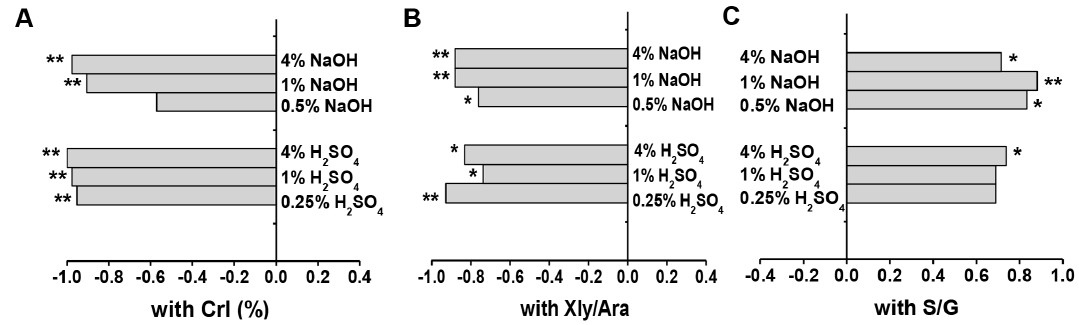
Figure 5. Correlation analysis between wall polymer features and hexoses yields from enzymatic hydrolysis after pretreatments. ( A ) Correlative coefficients between lignocellulose CrI (%) of raw material and the hexoses yields (% cellulose) released from enzymatic hydrolysis after NaOH and H 2 SO 4 pretreatments at three concentrations; ( B ) Coefficients with Xyl/Ara of the non-KOH-extractable hemicelluloses; ( C ) Coefficients with S/G of the non-KOH-extractable lignin. * and ** Indicated as significant correlations at p , 0.05 and 0.01 levels (n=8),